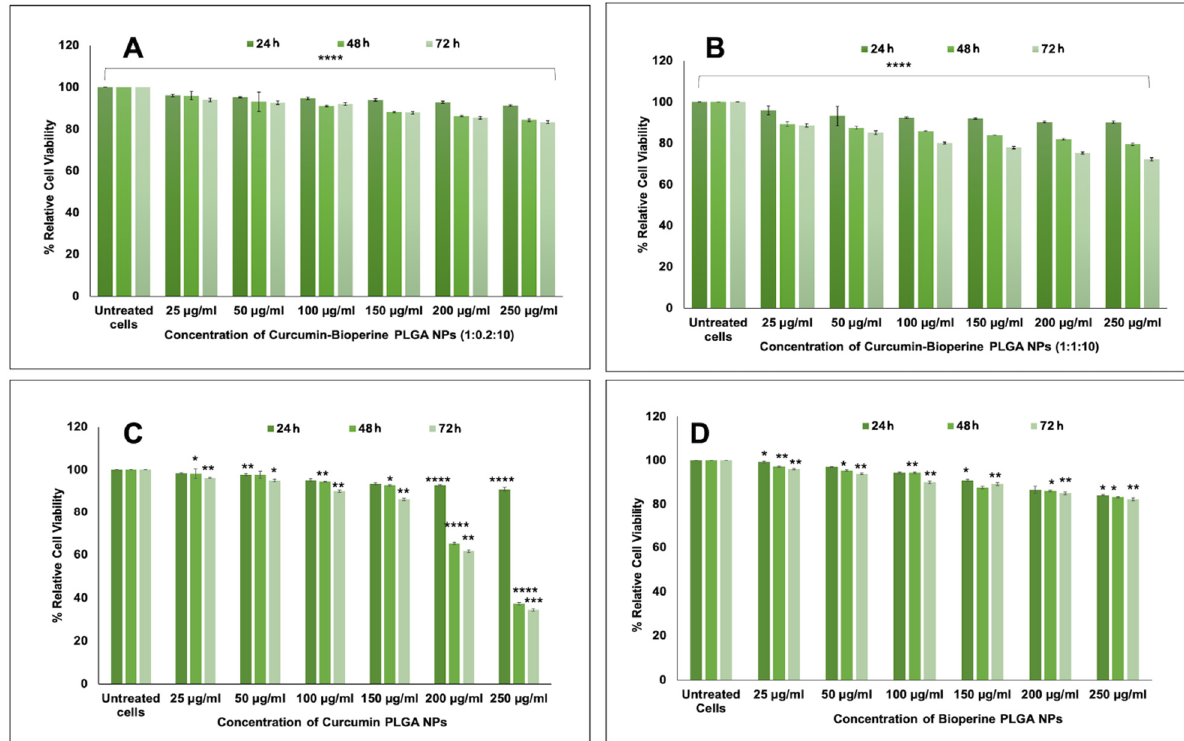
Figure 4. ( A ) % Relative cell viability of THP-1 monocyte-derived macrophage cells when treated with 1:0.2:10 ratio curcumin-Bioperine PLGA NPs for 24–72 h. ( B ) % Relative cell viability of THP-1 monocyte-derived macrophage cells when treated with 1:1:10 ratio curcumin-Bioperine PLGA NPs for 24–72 h. ( C ) % Relative cell viability of THP-1 monocyte- derived macrophage cells when treated with curcumin PLGA NPs for 24–72 h. ( D ) % Relative cell viability of THP-1 monocyte-derived macrophage cells when treated with Bioperine PLGA NPs for 24–72 h. (All the data for cell viability